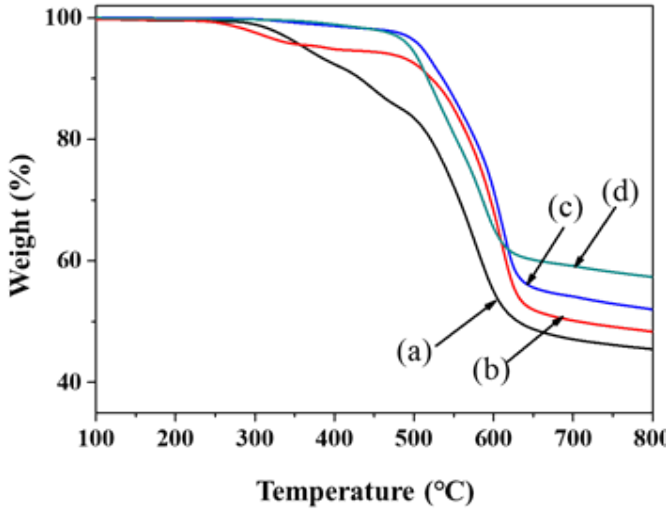
Figure 3. TGA thermograms of the pure PI and PI–silica composite films with various APTMS which were measured at a heating rate of 10 ◦ C/min: (a) pure PI, (b) PI–silica-2.5, (c) PI–silica-5.0, and contents, which were measured at a heating rate of 10 °C/min: (a) pure PI, (b) PI–silica-2.5, (c) (d) PI–silica-10.0 PI–silica-5.0, and (d) PI–silica-10.0 films.